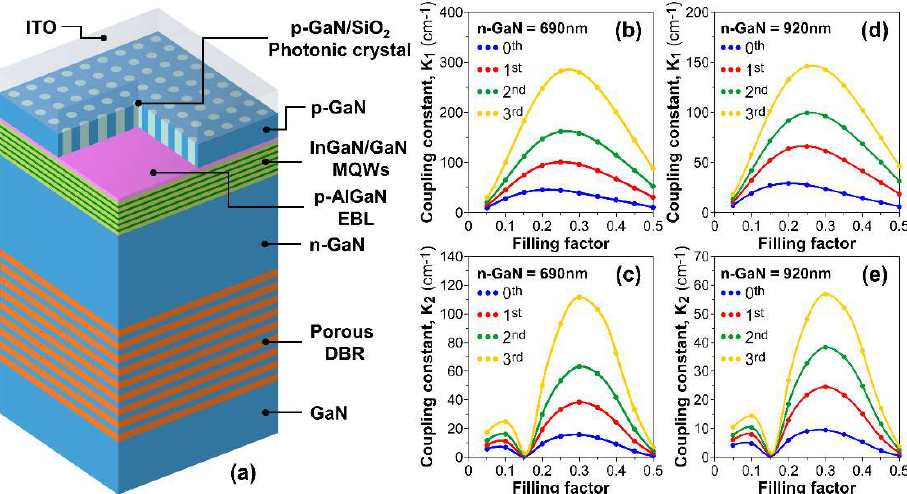
Figure 1. ( a ) Schematic of the InGaN-based µ-PCLED incorporated with the NP GaN DBR. ( b , c ) and ( d , e ) First- and second-order coupling constants of the µ-PCLED with n-GaN = 690 nm and 920 nm as a function of the filling factor. The PC period was set to 232 nm. Circles with different colors indicate the specific orders of FP modes.